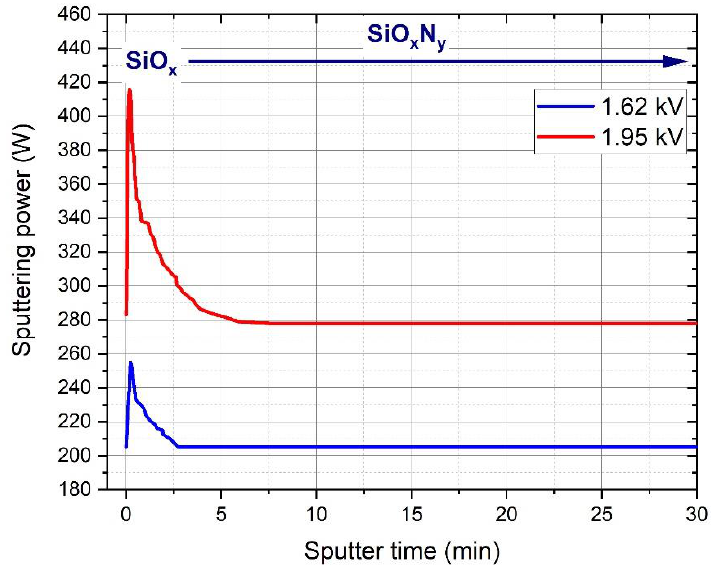
Figure 1. Transient behavior of the sputtering power during the initial stages of the deposition process for the samples sputtered at 1.62 and 1.95 kV voltages.